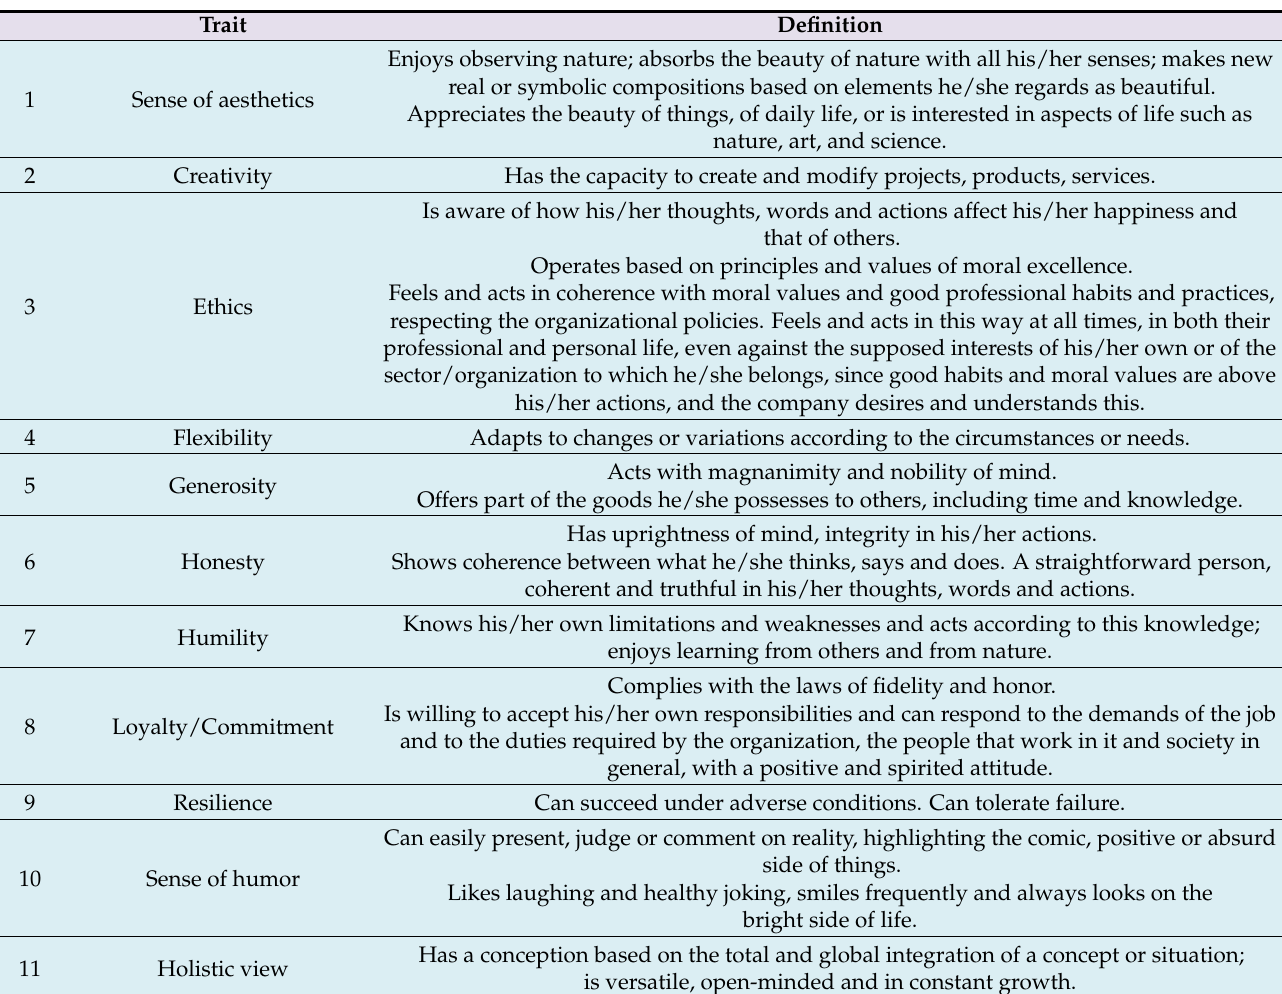
Table 4. Traits of the biomimetic